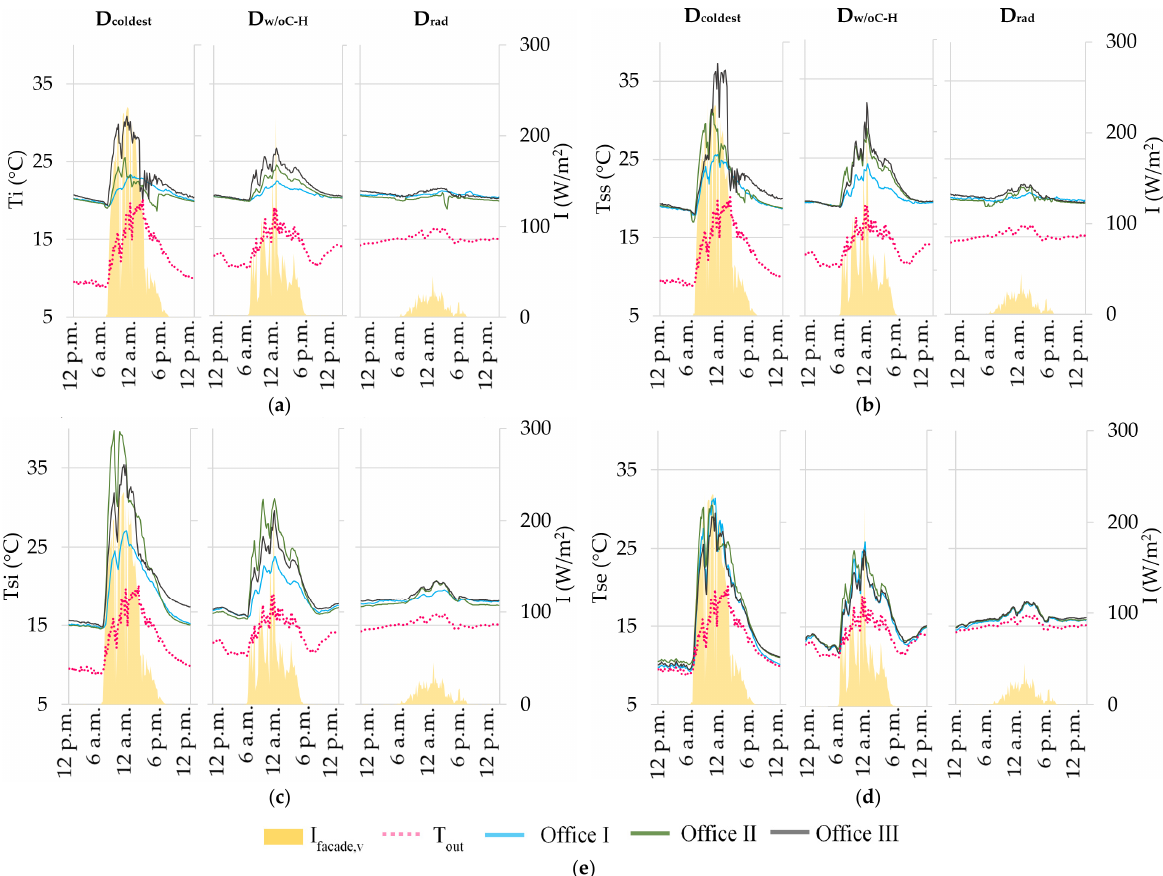
Figure 9. Experimental results for the heating period representative days: ( a ) indoor air temperature, T i ; ( b ) shading slats temperature, T ss ; ( c ) internal surface temperature of the glazing systems, T si ; ( d ) external surface temperature of the glazing systems, T s e ; ( e )